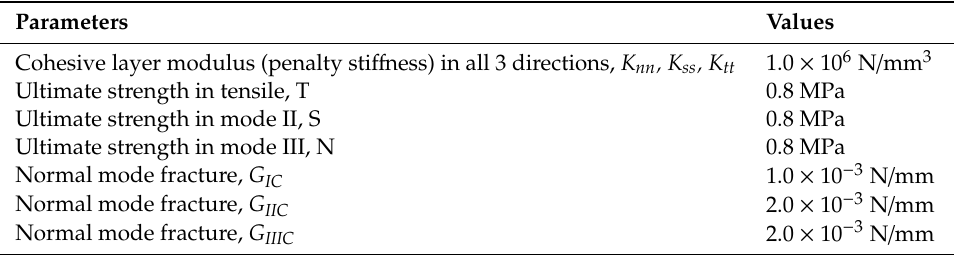
Table 2. Cohesive material